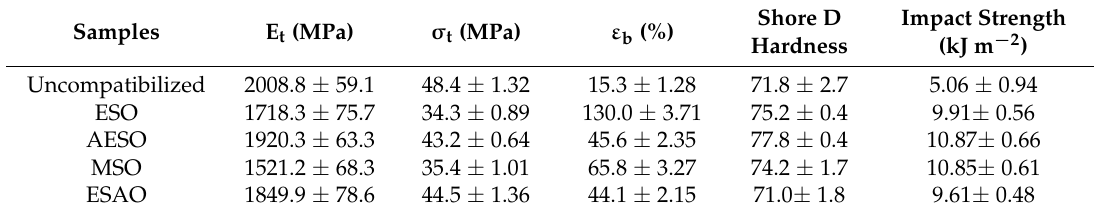
Table 1. Mechanical properties, tensile modulus (E t ), tensile strength ( σ t ), elongation at break ( ε b